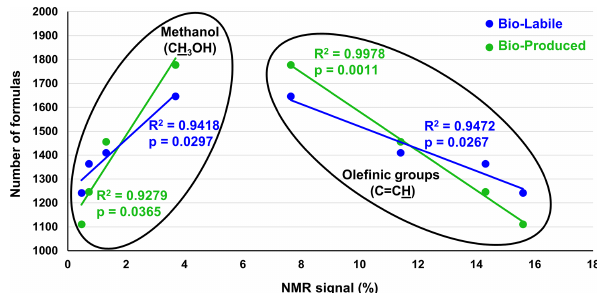
Figure 6. Pearson correlation analysis between the number of bio- labile and bio-produced formulas detected by FT-ICR-MS and rela- tive intensity (in %) of olefinic functionalities (C = C) and methanol (CH 3 OH) as measured by liquid-state 1 H NMR and reported by Bostick et al. (2021). No significant correlations were found be- tween other functional groups and the number of bio-produced or bio-labile formulas (data shown in Table